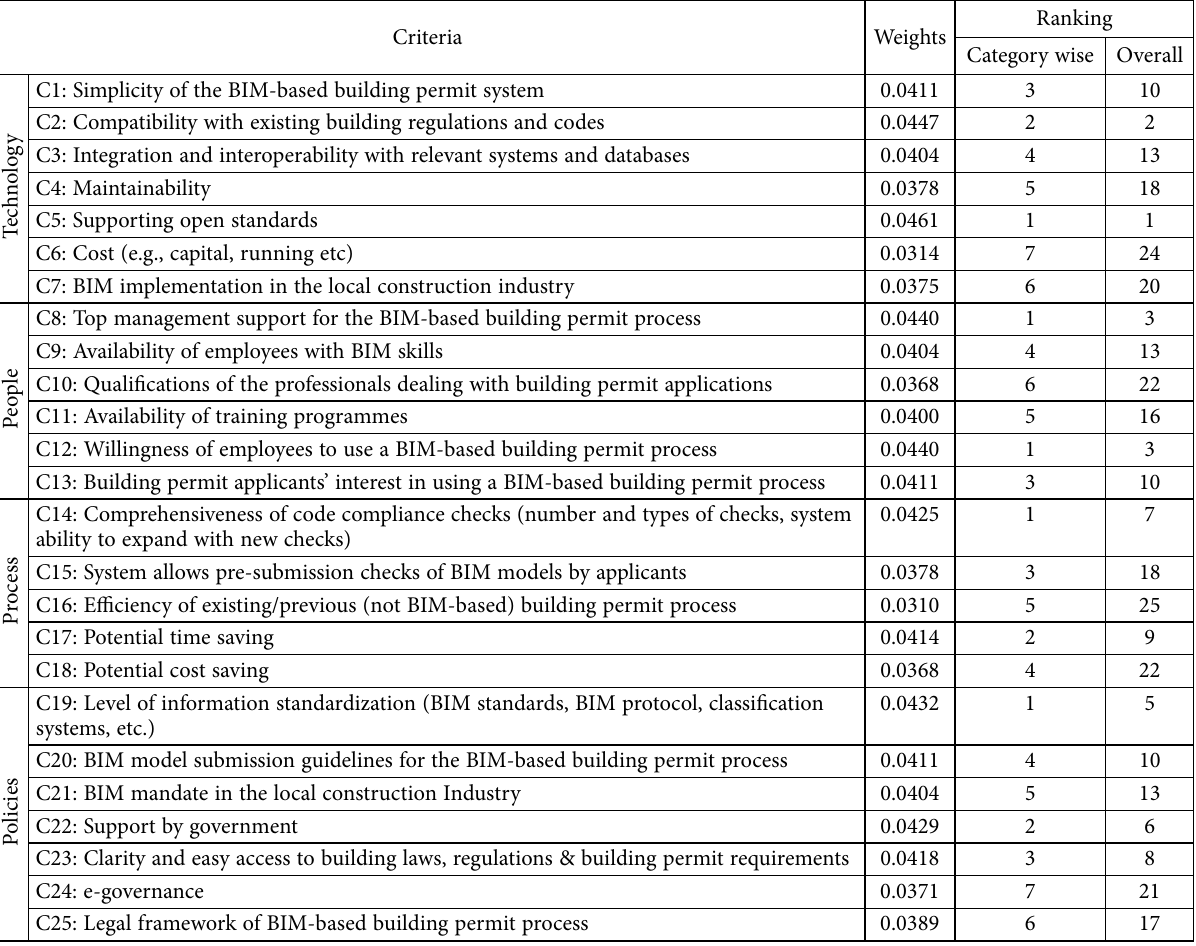
Table 6. Ranking of criteria